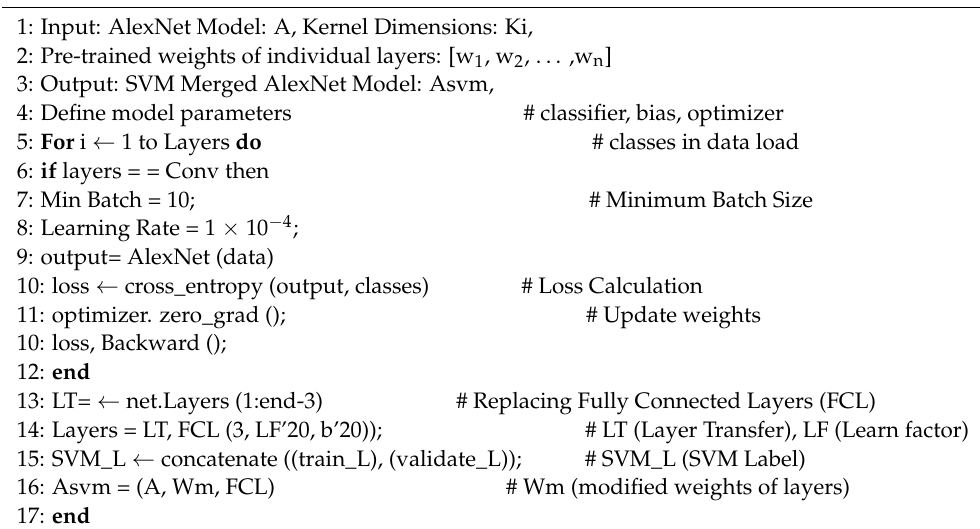
Algorithm 1 Function AlexNet-SVM (A, T,